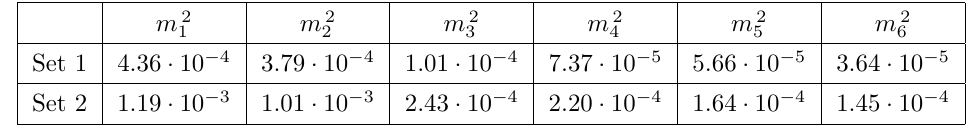
Table 2 . The canonically normalized masses squared for both sets of parameters are all